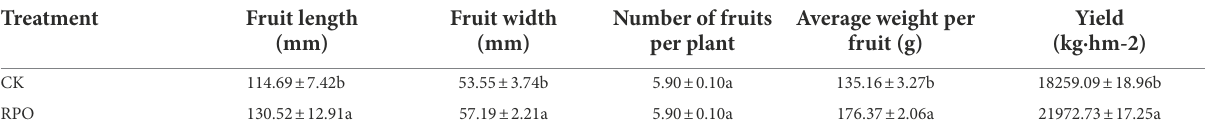
TABLE 4 Effect of RPO film on fruit yield of sweet